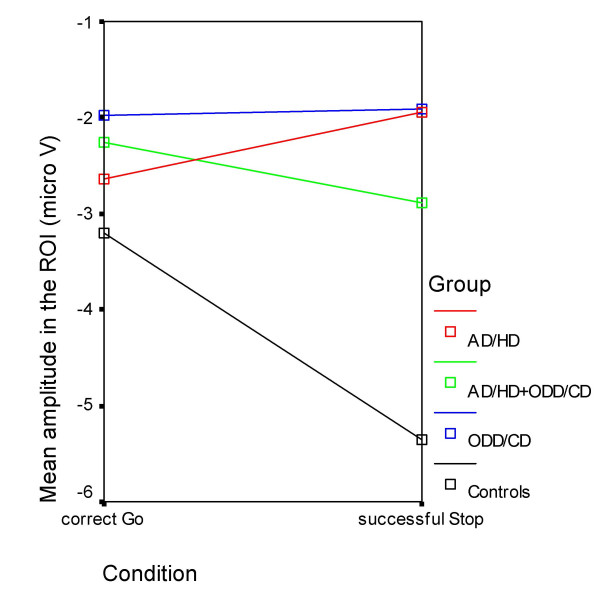
Mean Amplitudes in the region of interest. Mean amplitudes in the ROI for correct Go-trials and successful Stops. Normal controls (black), AD/HD (red), AD/HD+ODD/CD (green) and ODD/CD (blue).